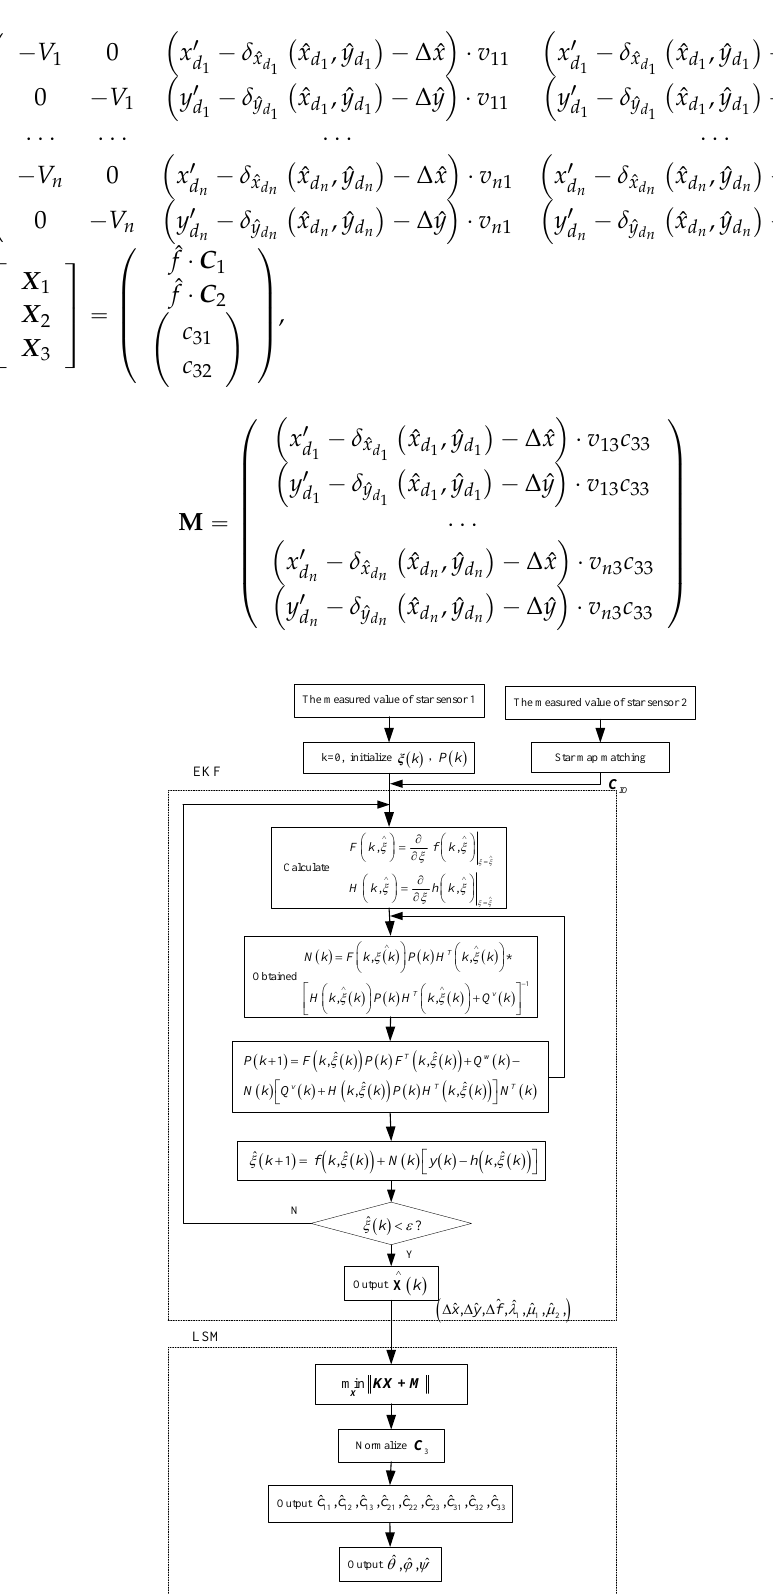
Figure 5. Flow chart of on-orbit calibration of double star sensors.